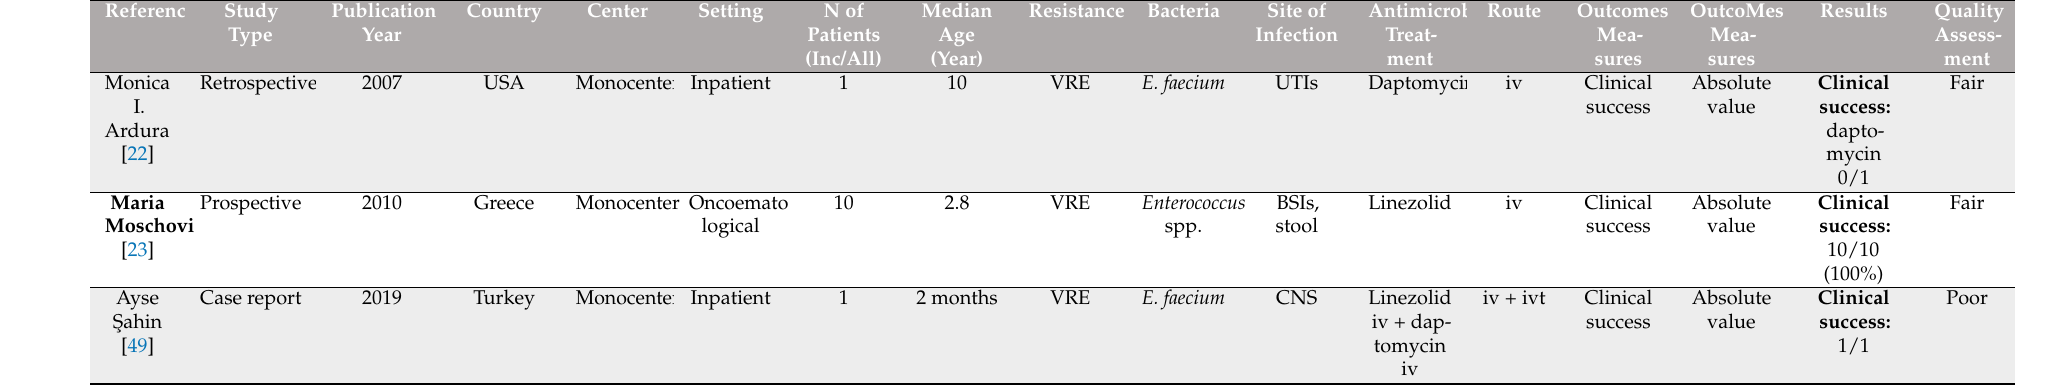
Table 2. Choice of treatment and outcomes for vancomycin-resistant Enterococcus